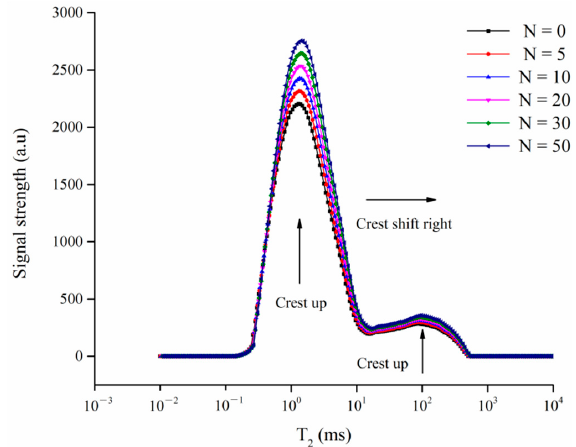
Figure 5. T 2 spectral curve distribution under different freeze–thaw cycles (N is the number of freeze–thaw cycles).